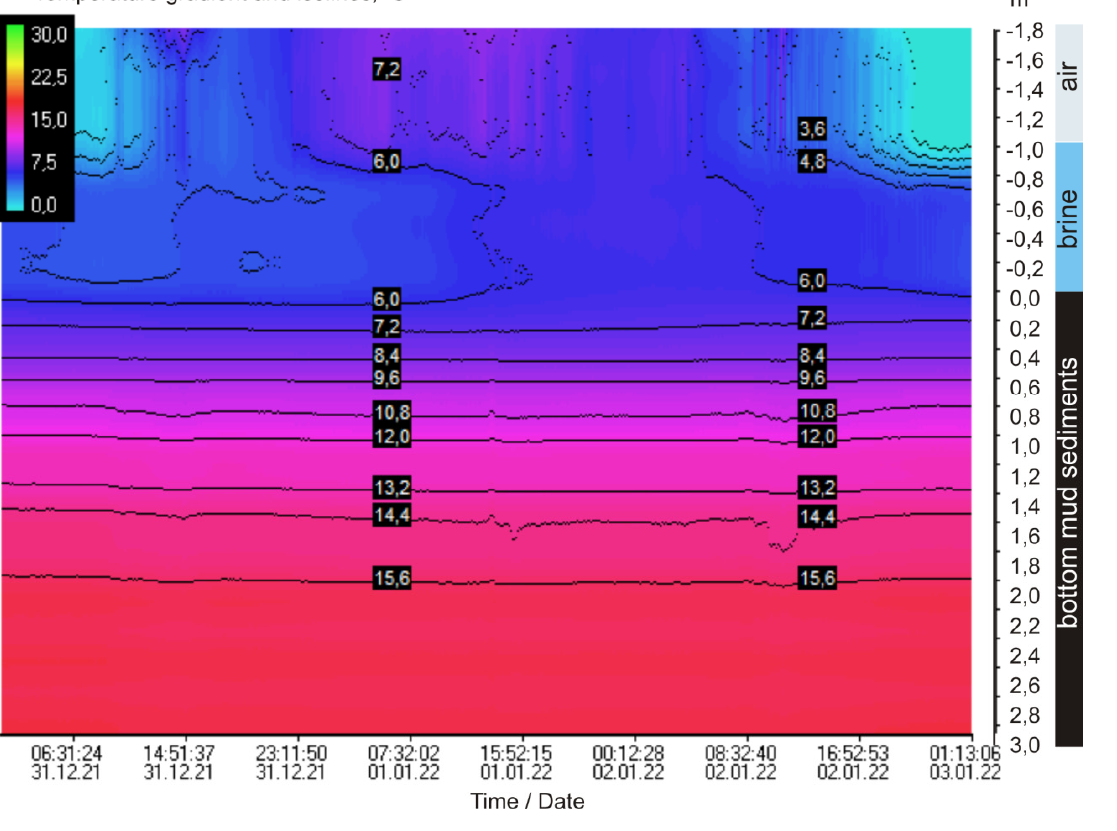
Figure 9. Typical pattern of vertical temperature distribution in isolines for winter period.